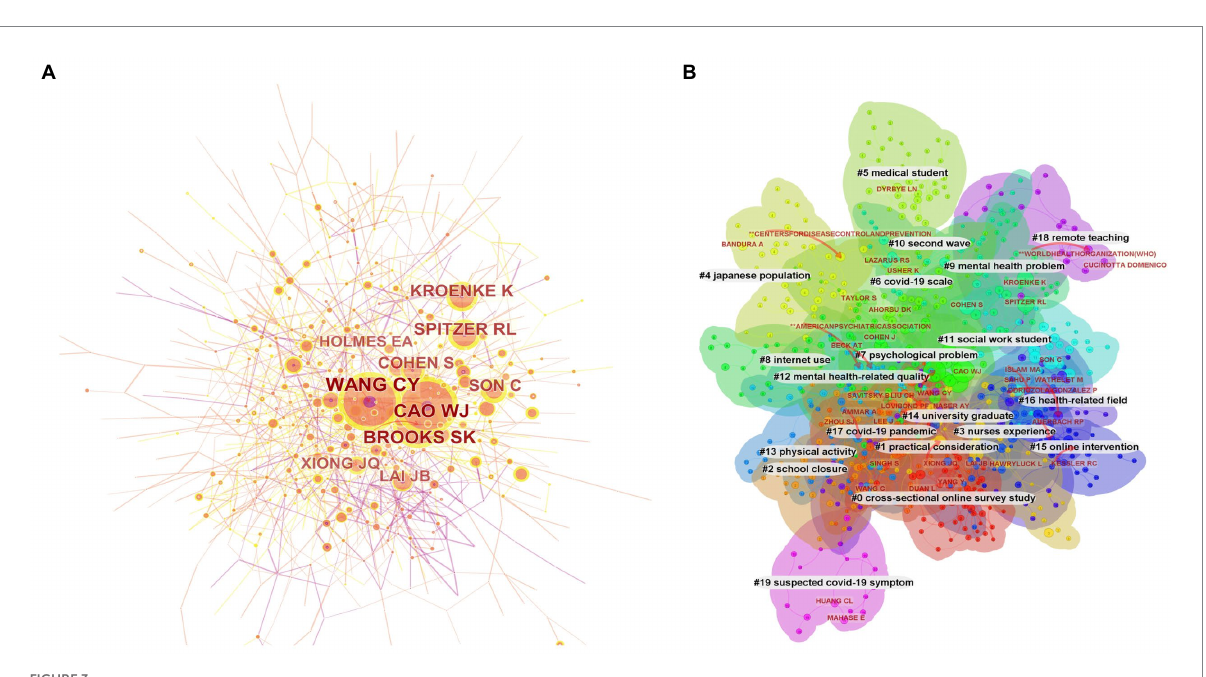
FIGURE 3 CiteSpace network visualization map of co-cited authors and their cluster results. (A) The co-cited author analysis. (B) Clusters of co-cited